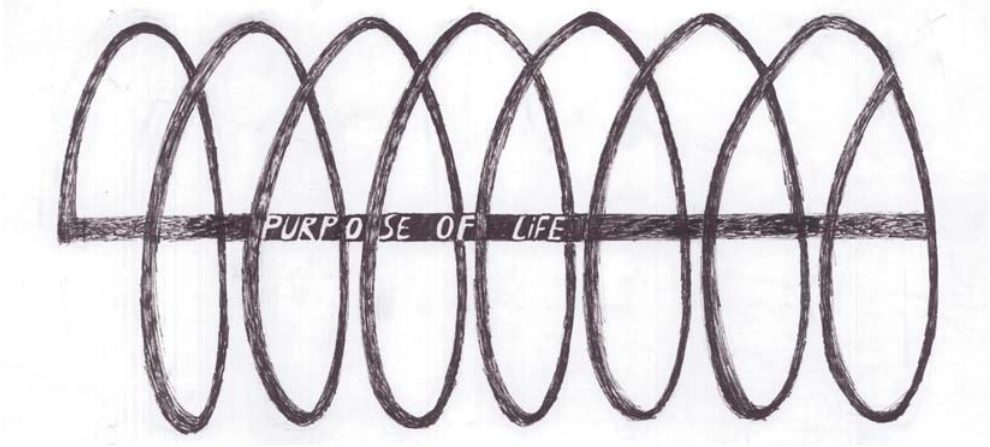
FIGURE 2. In our natural condition our existence can be compared with an energy-filled and dancing